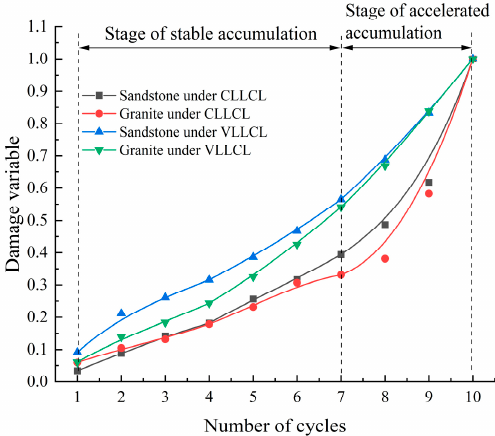
Figure 19. The damage evolution under different stress paths.